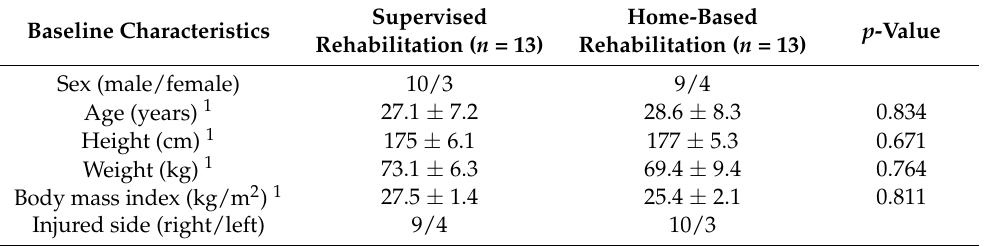
Table 1. Demographic data of participants in the supervised and home-based rehabilitation groups. Baseline Characteristics